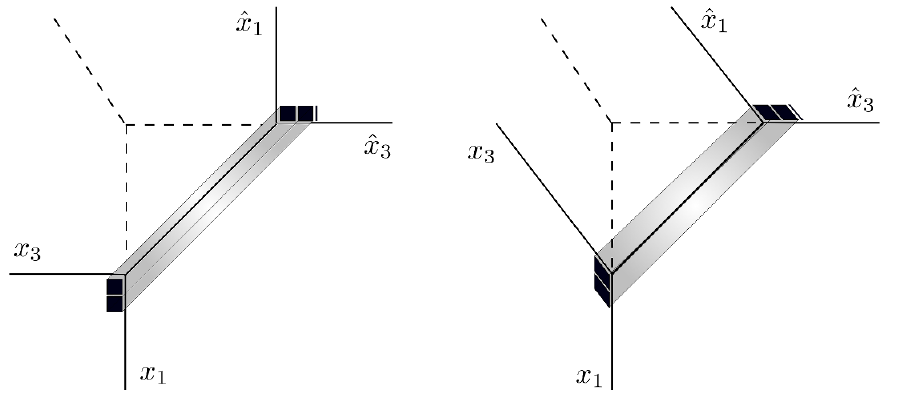
Figure 13 . Sketch of the box interpretation of gluing generators, where the room is viewed as the base of the T 3 (cid:12)bration of the toric Calabi-Yau threefolds corresponding to p = 0 and p = (cid:0) 1. asymptotic shape of the hatted partition. This phenomenon is especially natural from the viewpoint of twin-plane partition asymptotics, if viewed from a 3d perspective as illustrated by (cid:12)gure 13. There, in(cid:12)nite rows of boxes on one side appear from the other side as in(cid:12)nite rows of anti-boxes, or high-walls. On the left we show a con(cid:12)guration with two rows for p =0. On the right we show a con(cid:12)guration with two rows for p = (cid:0) 1. (cf. (cid:12)gures 11 and 12) The relative orientations of asymptotic shapes along the x derived from table